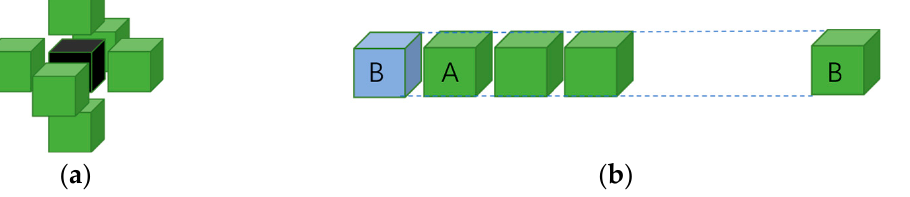
Figure 2. Cellular Automata (CA) calculation rules. ( a ) a Moore neighborhood rules of CA; ( b ) a periodic boundary of CA.